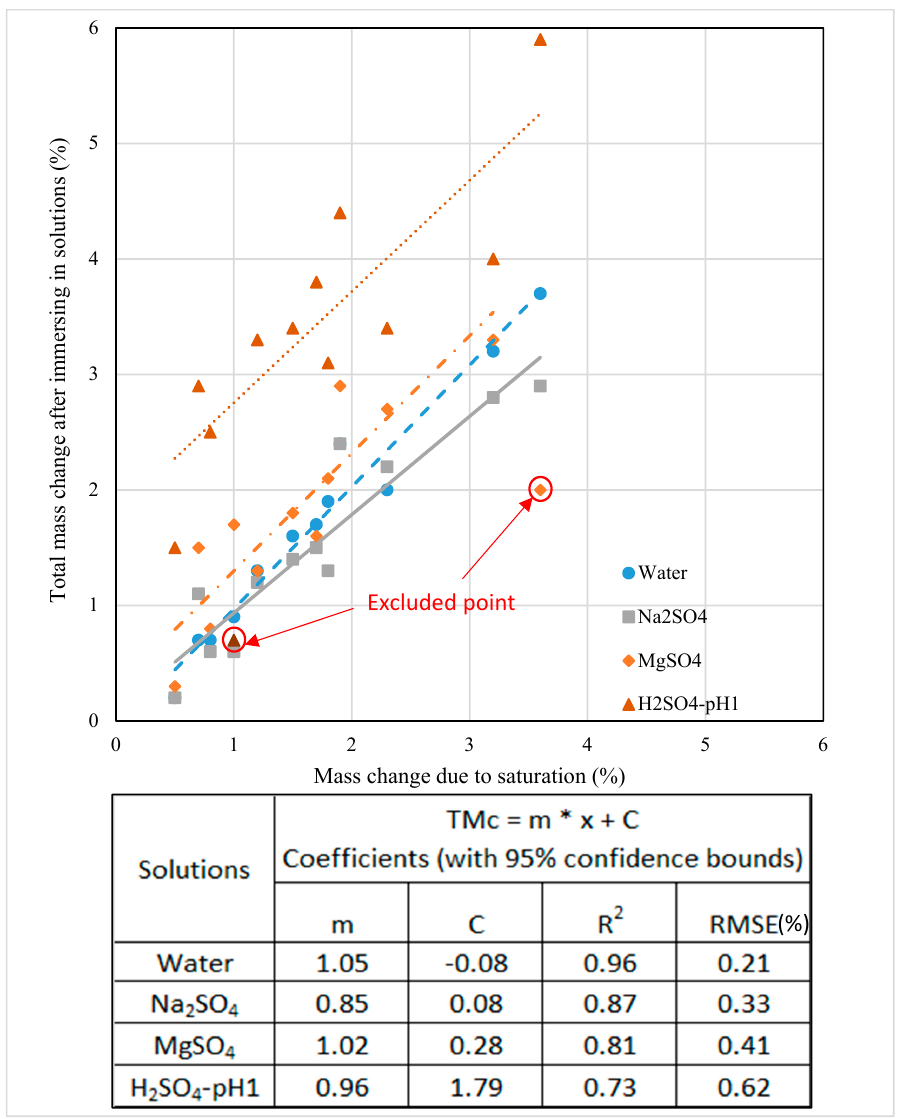
Figure 9. Total mass change of mixes (%) after immersion in solutions against saturation mass change (%) (x = mass change (%) due to saturation).